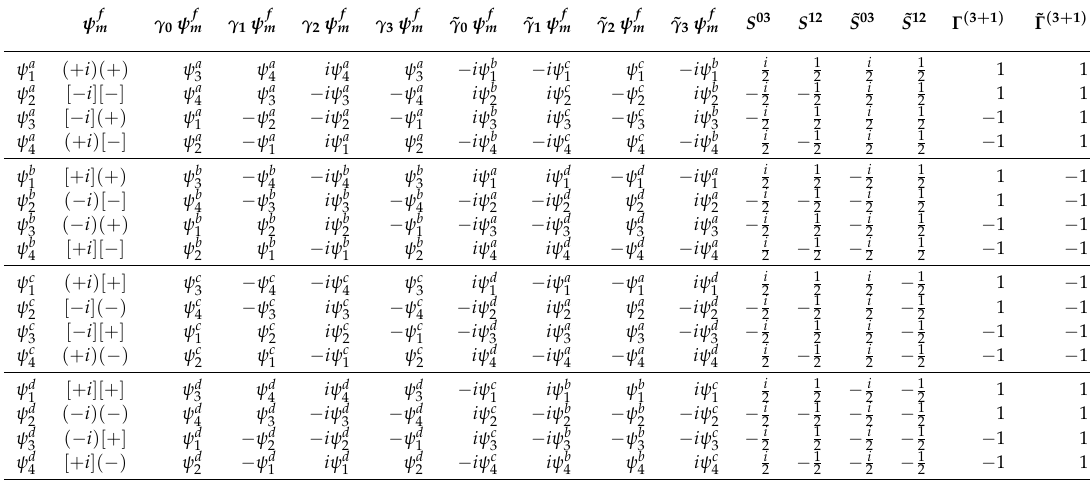
Table 2. In this table 2 d = 16 vectors, describing internal space of fermions in d = ( 3 + 1 ) , are presented. Each vector carries the family member quantum number m = ( 1,2,3,4 ) —determined by S 03 and S 12 , Equations (6) and (7)—and the family quantum number f = ( a , b , c , d ) —determined by ˜ S 03 and ˜ S 12 , Equations (6) and (7). Vectors ψ f m are obtained by applying ˆ b f † m on the vacuum state, Equation (9). Vectors, that is the family members of any family, split into even (they are sums of products of an even number of γ a ’s) and odd (they are sums of products of an odd number of γ a ’s). If these vectors are embedded into the vectors of d = ( 5 + 1 ) (by being multiplied by an appropriate nilpotent or projector so that they are of an odd Clifford character), they “gain” charges as presented in Table